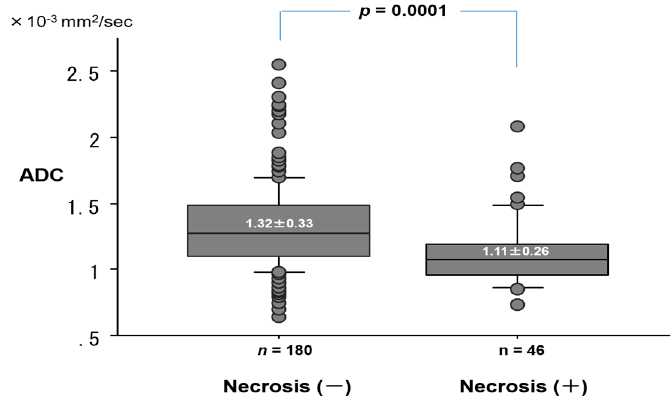
Figure 7. ADC value by the presence of mucin component in lung cancer.